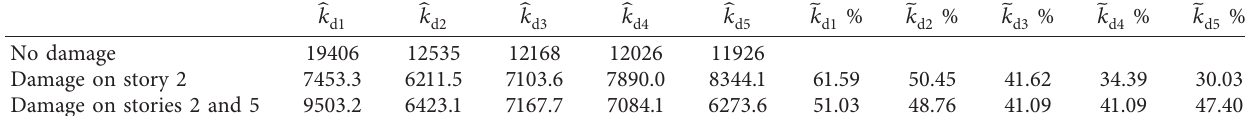
Table 6: Comparison of nominal and estimated stiffness after damage.